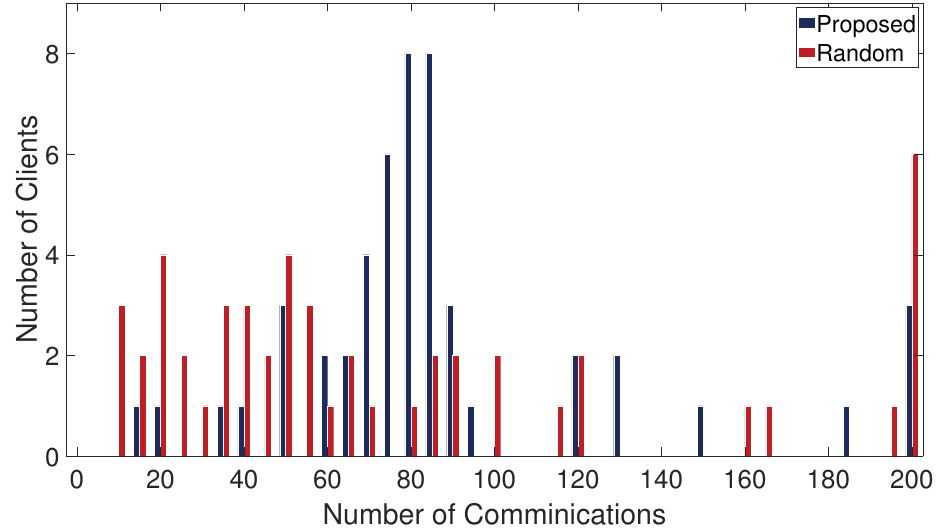
Figure 11. Number of clients for each number of